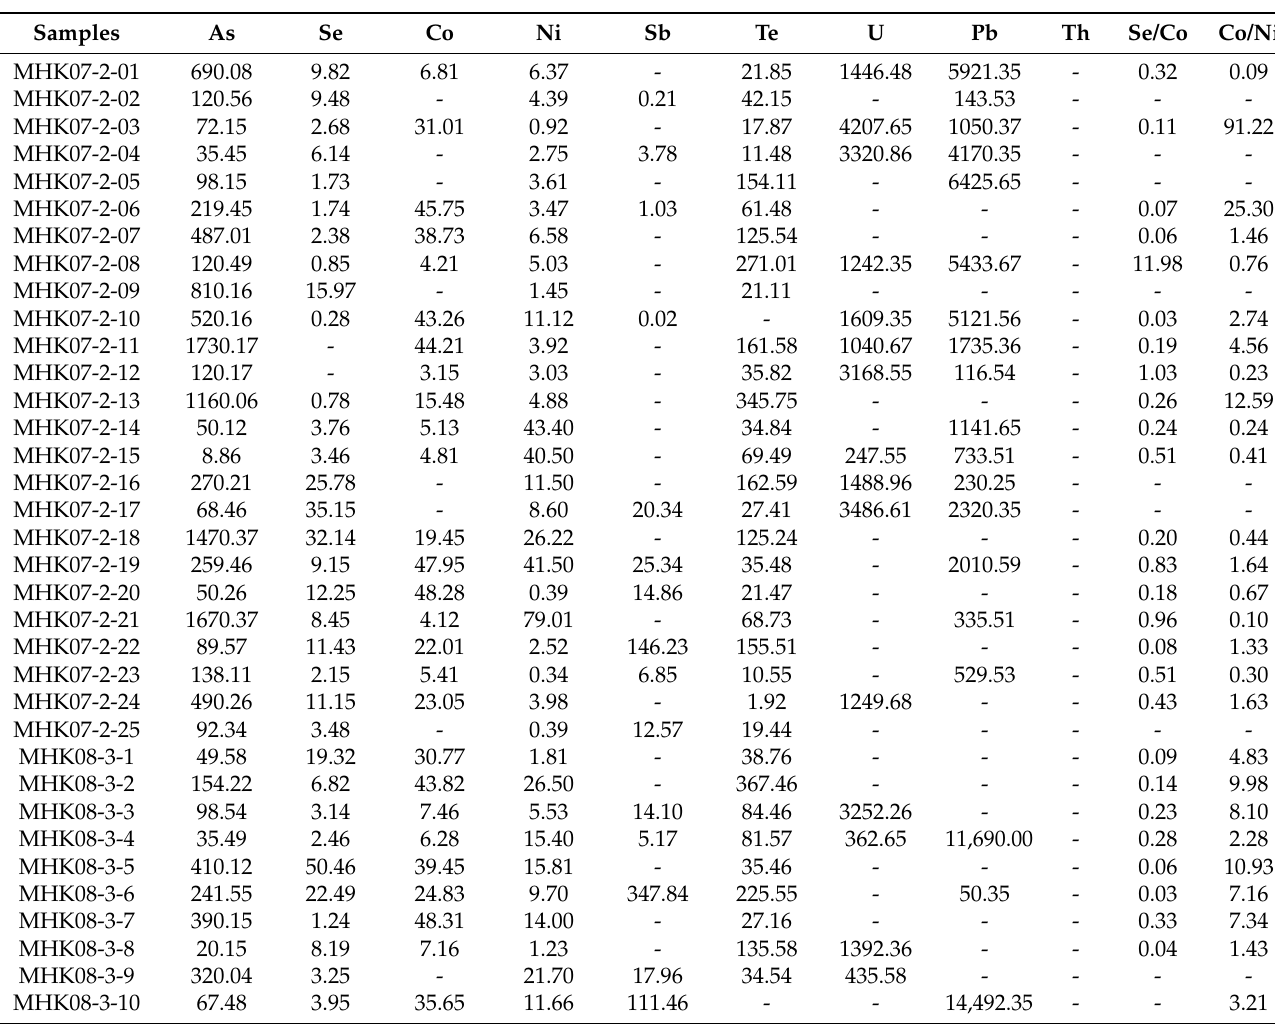
Table 2. The LA-ICPMS analysis of trace element concentrations (ppm) for syn-mineralization pyrite. “-” means “below detection